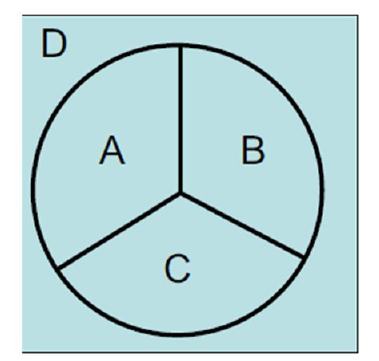
Figure 4 . The Kitaev-Preskill construction allows for the isolation of topological entan- glement entropy in two dimensions [14].